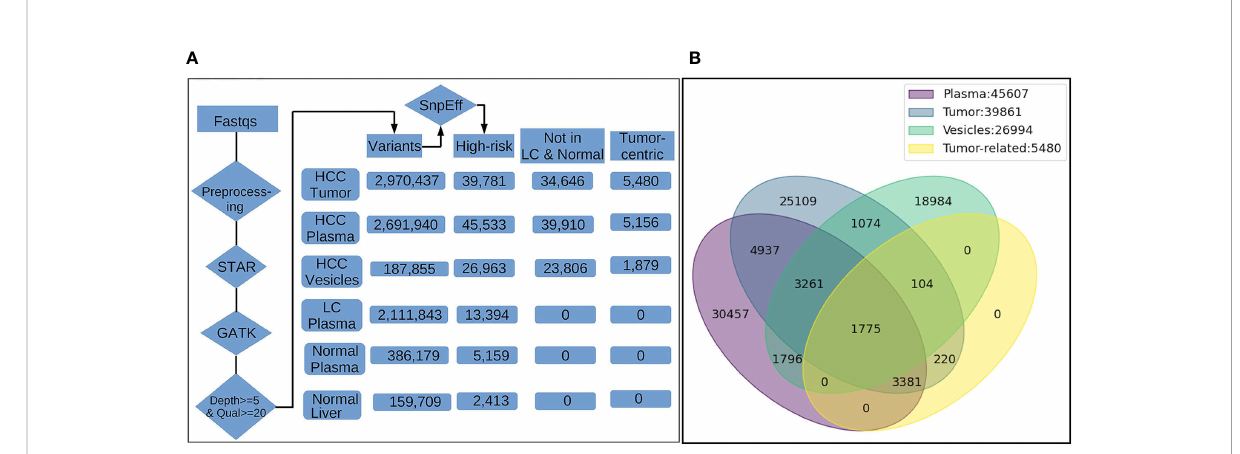
FIGURE 2 Filtration summary for derivation of high-risk HCC-speci fi c mRNA variants and concordance of detection between different sample subsets from HCC patients. (A) . The FASTQ fi les from NGS platform (illumina) were pre-processed to remove the residual of sequencing adapter in the fi les. The trimmed data were input into STAR, an aligner for RNA-Seq mapping, for alignment against human reference genome GRCh38. The alignments (BAM) were processed with GATK tools (v4.1.7.0) for spliting on reads with N cigar, base quality score recalibration, and variants calling by HaplotypeCaller. The variants reported by GTAK were fi ltered by depth (>=5) and quality (>=20) and annotated with snpEff for location on genes/transcripts, mutation type and putative biological impact. The number in the boxes indicate the total unique variants identi fi ed in samples of different groups. Variants occurred in multiple samples within the same group were counted once only. Only high-risk variants and those with highest frequency in tumors and HCC plasma were considered during enrichment. High-risk variants also detected in the circulation of liver cirrhosis patients and normal healthy individuals were excluded leading us to cancer-associated high-risk variants referred to as tumor- centric variants. (B) . Venn diagram showing the distribution and overlap of tumor-centric variants with total high-risk variants in various sample sources. The number of High-risk variants identi fi ed only in a single sample type either plasma, tumor and vesicles are 30,457, 25,109 and 18,894, repectively, re fl ecting the heterogeneity and difference in variant pro fi les attributed to the source of RNA. However, there are still 5,036 variants occurring in RNA from all three sources. Furthermore, 1,775 of them were among 5,480 tumor-related variants identi fi ed by tumor- control comparison, suggesting the plasma/vesicle RNA share abundant/signi fi cant transcripts carrying the tumor associated variants.